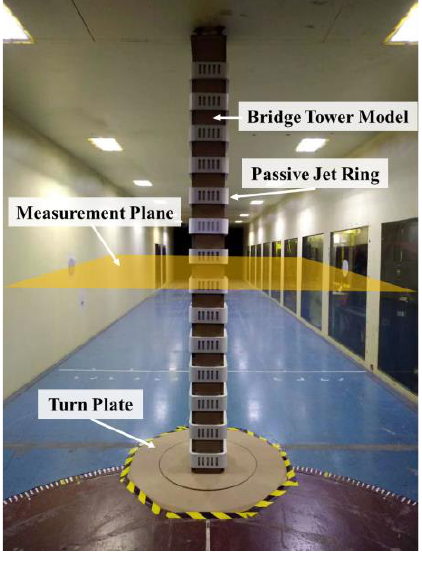
Figure 1. Schematic diagram of test layout